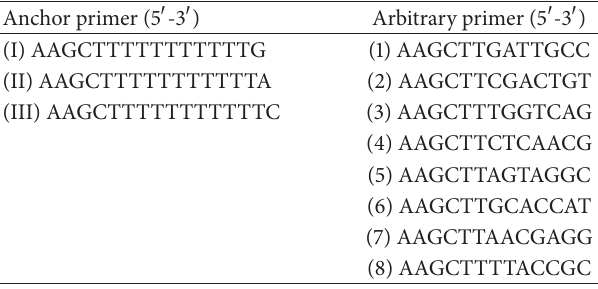
Table 1: Primers used in the DDRT-PCR